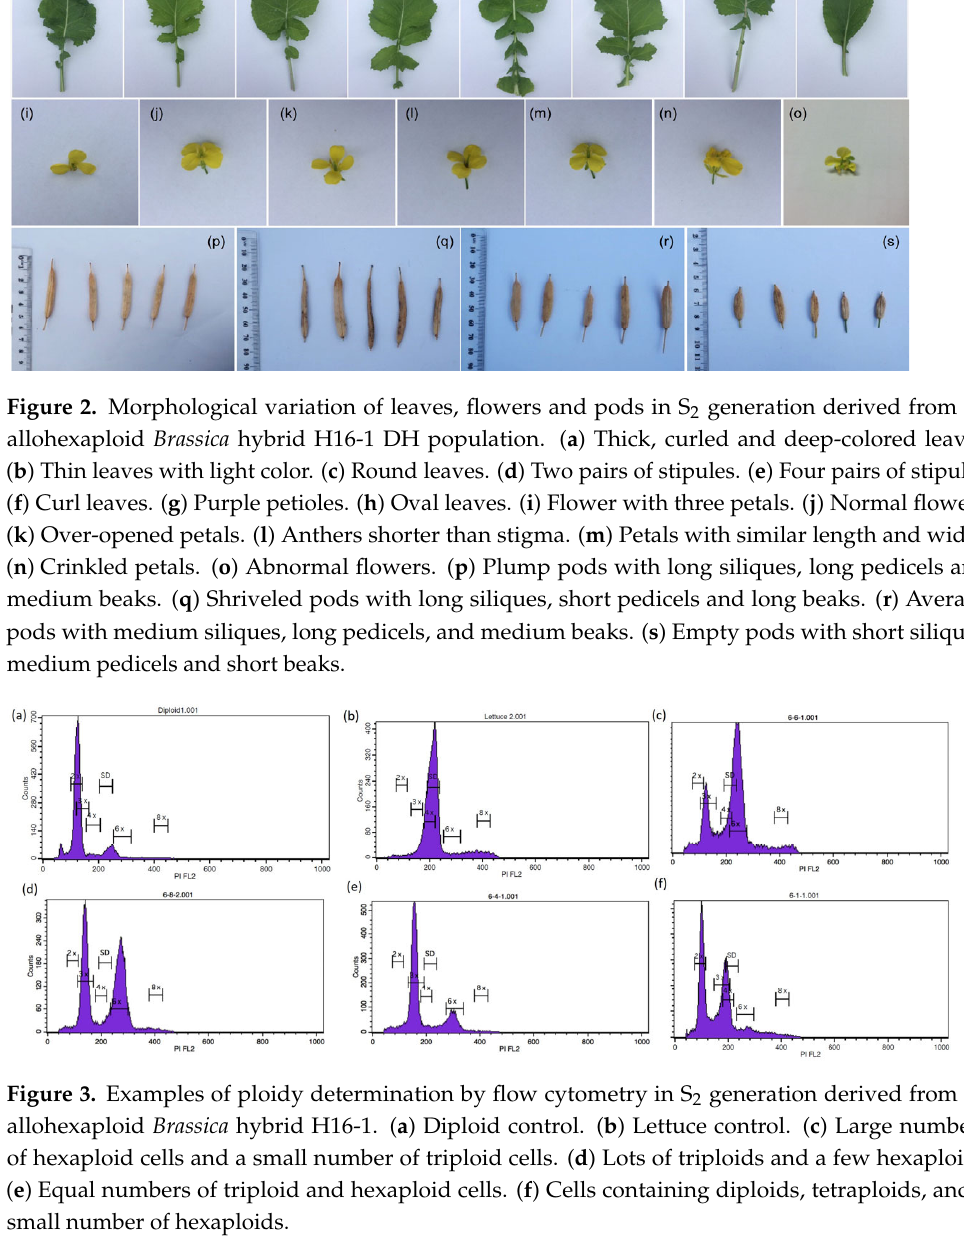
Table 2. Phenotypic variation among three different groups (C1, C2 and C3 goup) in S 2 generation derived from a hexaploid Brassica hybrid H16 ‐ 1.